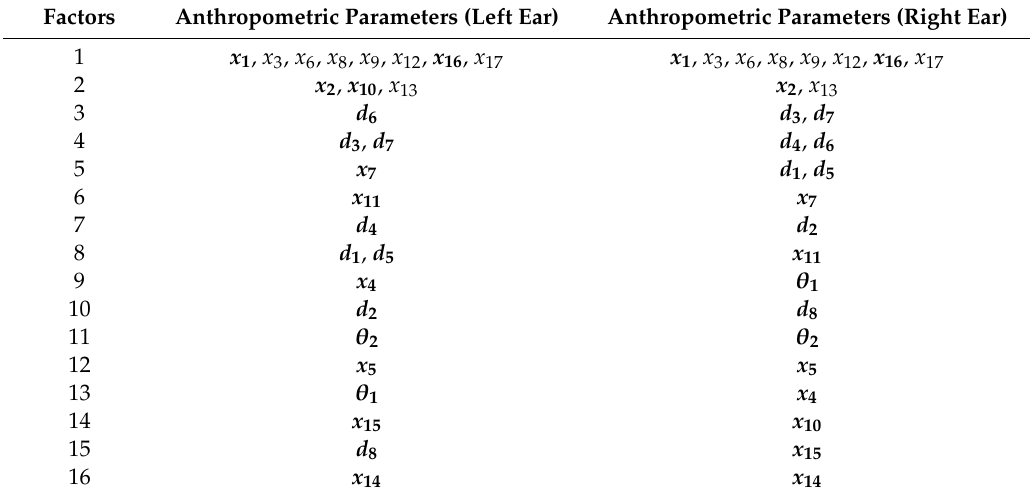
Table 3. Anthropometric parameters in the 16 common